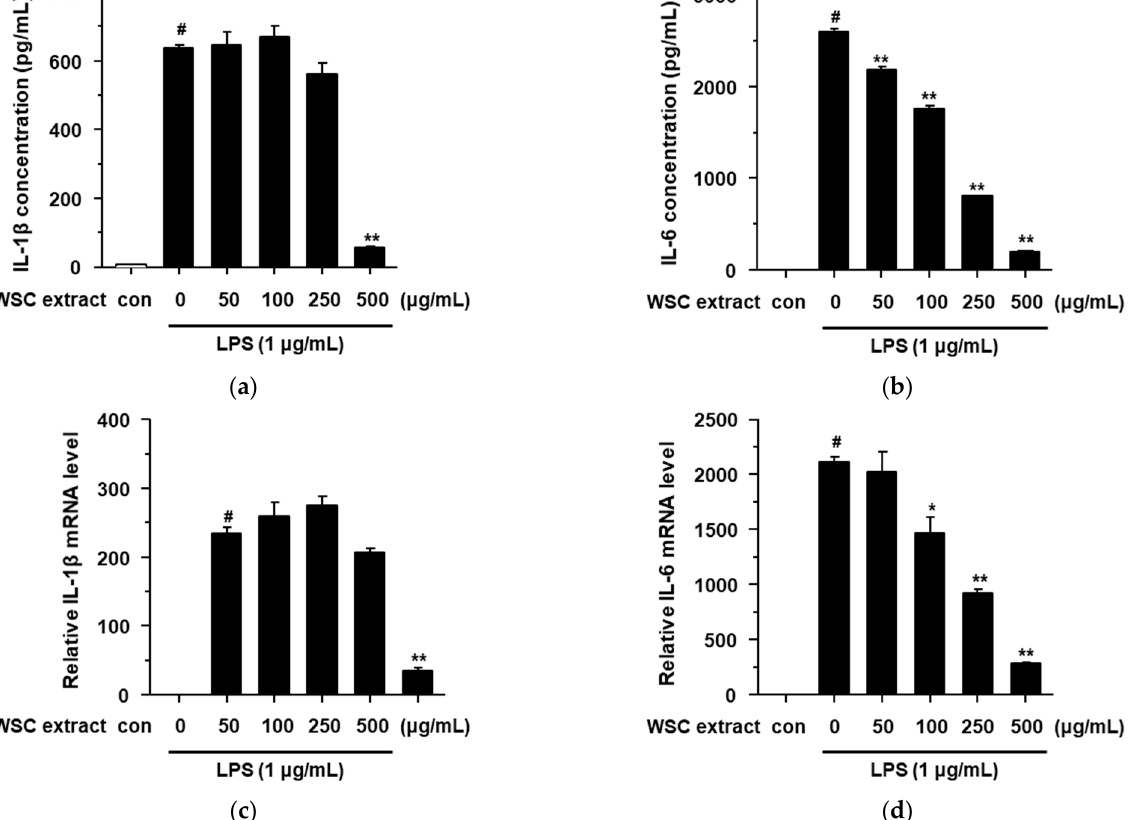
Figure 4. Effects of the WSC extract on LPS-stimulated pro-inflammatory cytokines in RAW264.7 cells. The cells were pretreated with the indicated concentrations of the WSC extract for 3 h and then treated with 1 μ g/mL of LPS for 24 h: ( a , b ) Protein levels of IL-1 β and IL-6 were determined by ELISA; ( c , d ) IL-1 β and IL-6 mRNA levels were measured by quantitative real-time PCR. Values are expressed as the mean ± standard deviation of three independent experiments; #, p < 0.05 versus control; *, p < 0.05; **, p < 0.005 versus LPS alone.